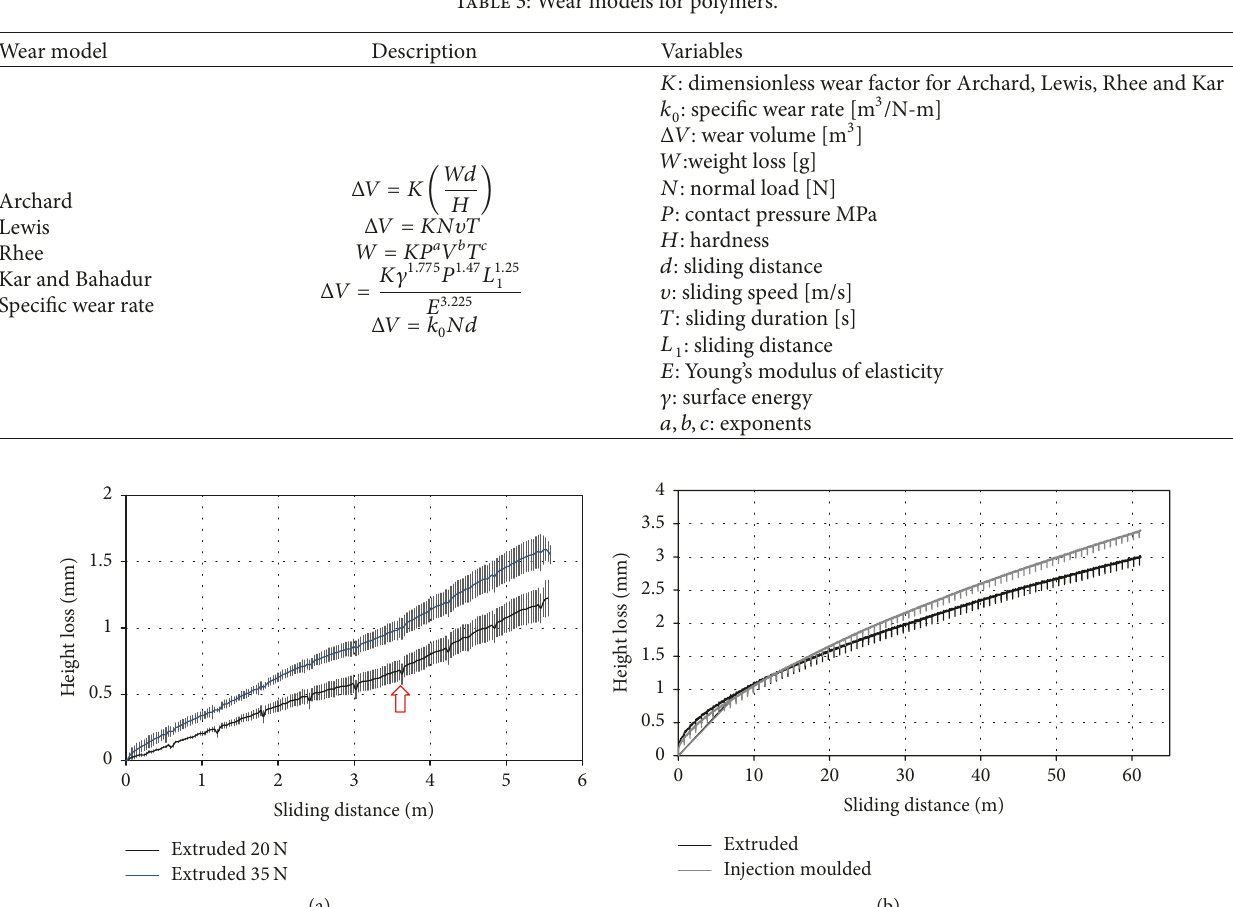
Figure 2: Height loss as a function of time. (a) Extruded sample (E) (20 N and 35 N) tested with single pass using P100. (b) Extruded and injection moulded sample (20 N) tested with multipass using